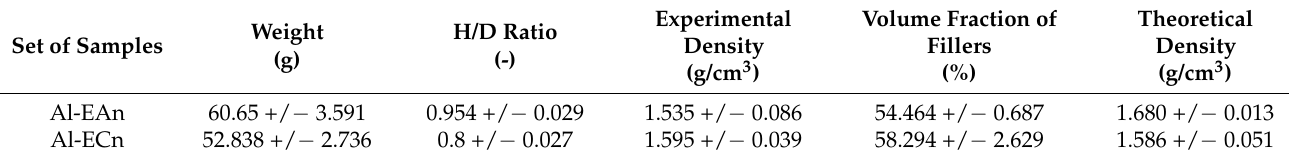
Table 3. Average values of physical properties of rectified and heat-treated ASFs.